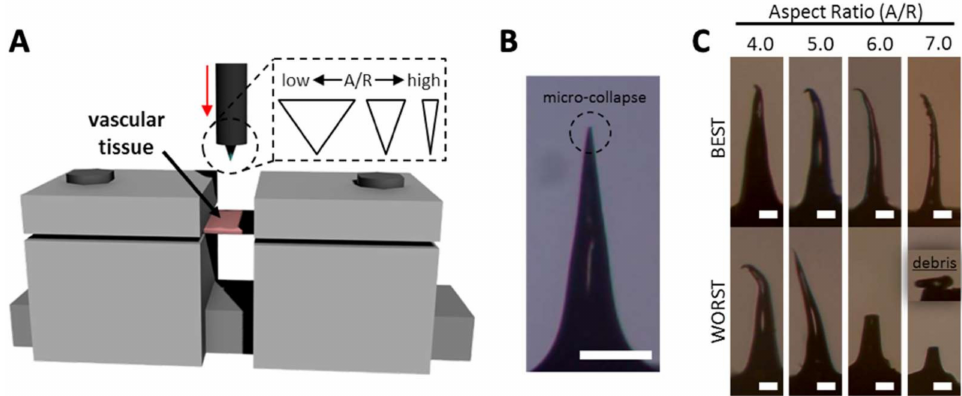
Figure 6. ( A ) A schematic image of ex vivo vascular tissue insertion setup. ( B ) Aspect ratio (A/R) 3.5 microneedle (MN) having micro-collapse at the apex. ( C ) Best and worst case of different A/R of MNs (scale bar = ( B ) 200 µ m, ( C ) 50 µ